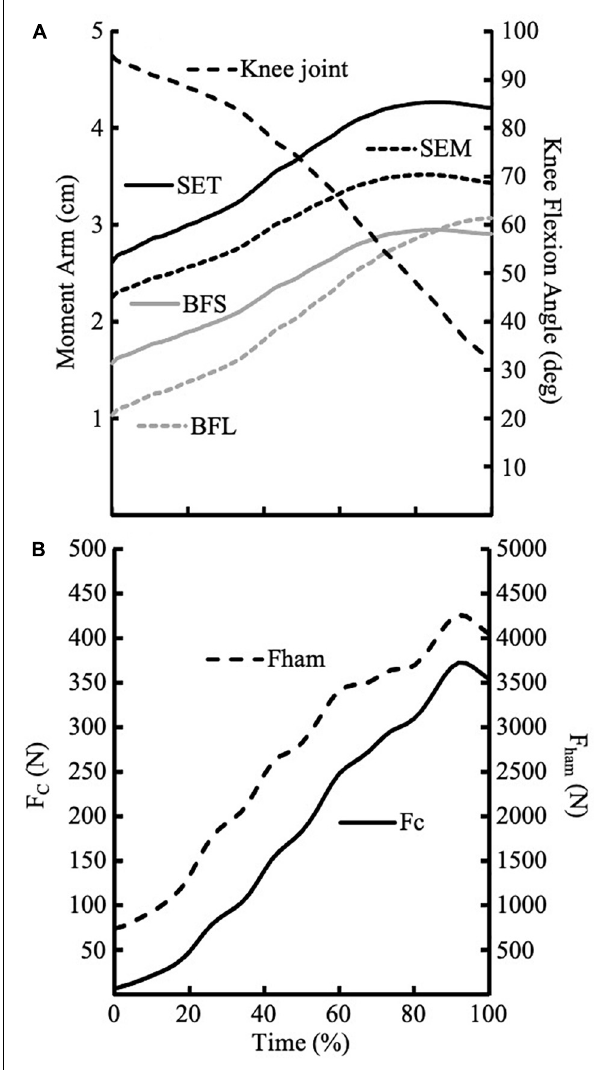
FIGURE 2 | (A) Exemplar traces of moment arms for four muscles during Nordic hamstring exercise from one participant. The knee joint angle was flexed at 90 ◦ at the beginning of the trial and the decreasing to about 35 ◦ knee flexion at the end of the trial. (B) Exemplar traces of F c and F ham during Nordic hamstring exercise from one participant.